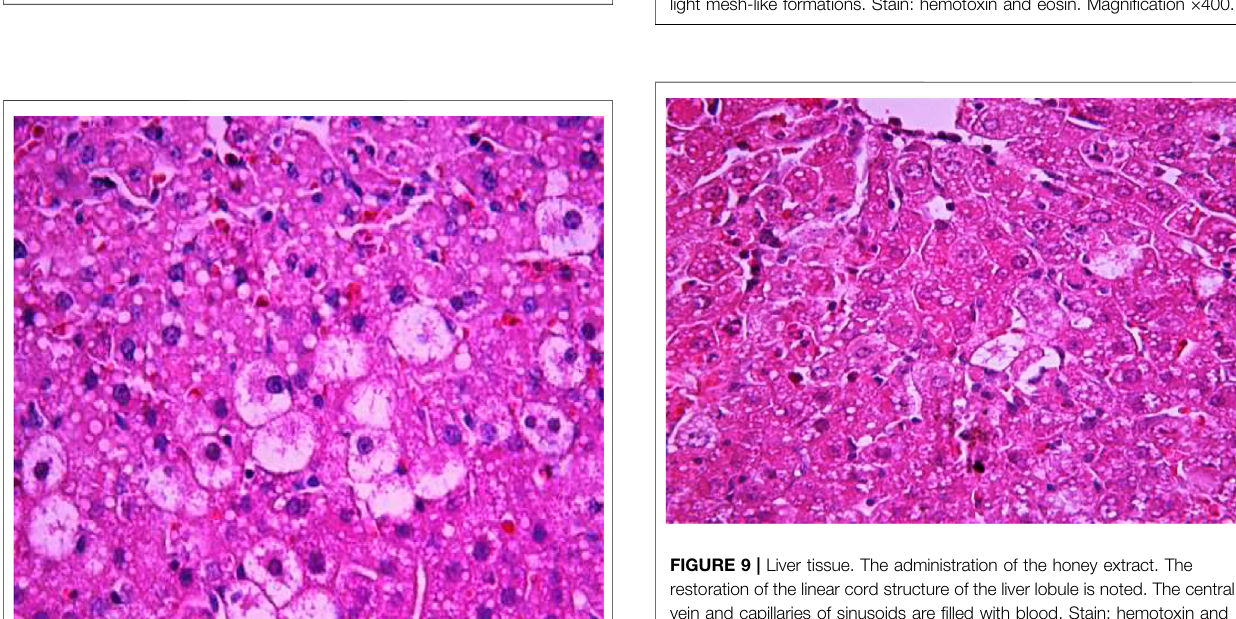
Frontiers in Pharmacology |